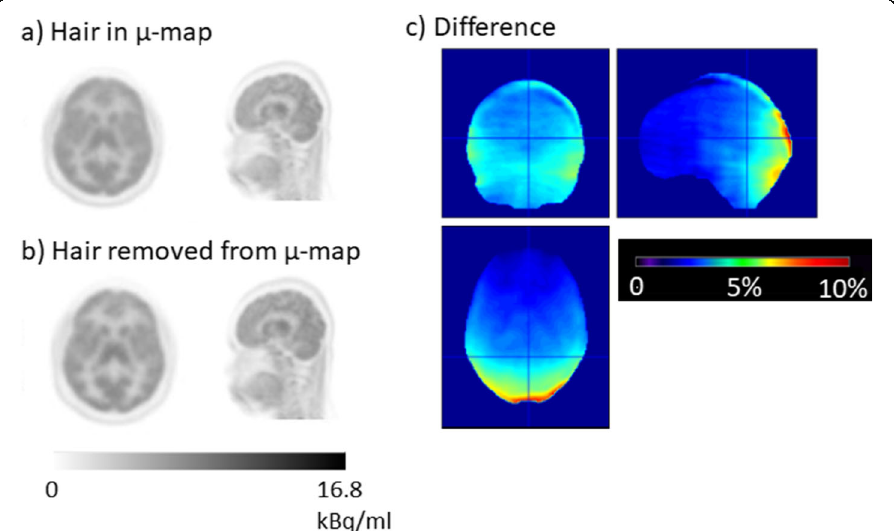
Fig. 8 a PET scan reconstructed with the hair in the μ -map. b PET scan reconstructed with the hair removed from the μ -map. c Transverse, coronal and sagittal view showing the percentage difference between the PET image attenuation-corrected using a CT with the hair included compared to the image corrected using a CT with the hair masked